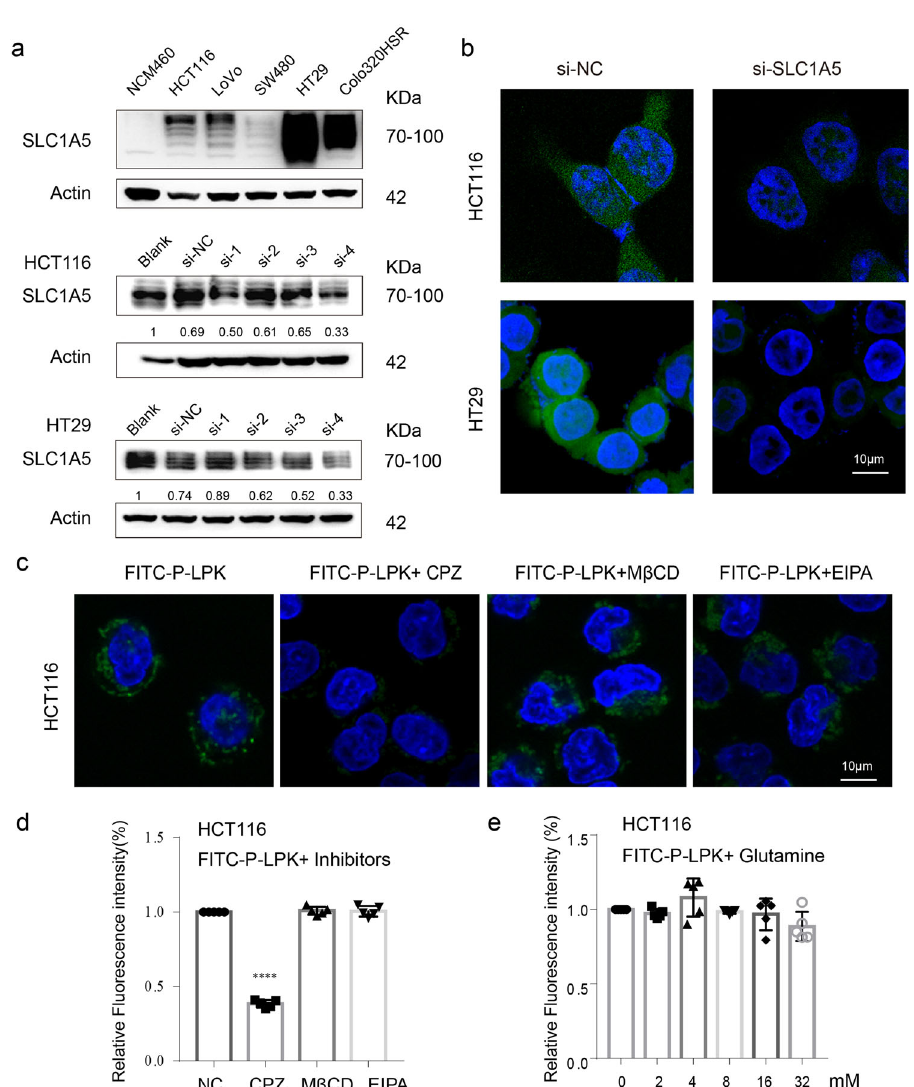
Fig. 6 P-LPK bound to SLC1A5 and entered CRC cells through endocytosis. a , b Western blotting analysis of SLC1A5 in NCM460, HCT116, LoVo, SW480, HT29 and Colo320HSR cells. After knocking down SLC1A5 in HCT116 and HT29, the binding intensity of FITC-P-LPK to cells was observed by confocal microscopy. Bar, 10 μ m. c , d Effects of different endocytosis inhibitors on the internalization of FITC-P-LPK. HCT116 cells were pre-treated with 10 µ M chlorpromazine, 50 μ M methyl- β -cyclodextrin, 20 µ M Amiloride hydrochloride for 30 min at 37 °C. Subsequently, the cells were incubated with FITC-P- LPK for 2 h. Then the fl uorescence intensity was observed by confocal microscopy and detected using a multi-well plate reader ( n = 5, means ± SD, NC vs CPZ, p = 0.0001; NC vs M β CD, p = 0.9069; NC vs EIPA, p = 0.9812) (**** p < 0.0001). Bar, 10 μ m. e The competition experiment with SLC1A5 substrates glutamine. FITC-P-LPK was incubated with increasing concentrations (0 – 32 mM) of glutamine in HCT116 cells at 37 °C for 2 h. The fl uorescence intensity was measured in a multi-well plate reader ( n = 5, means ±